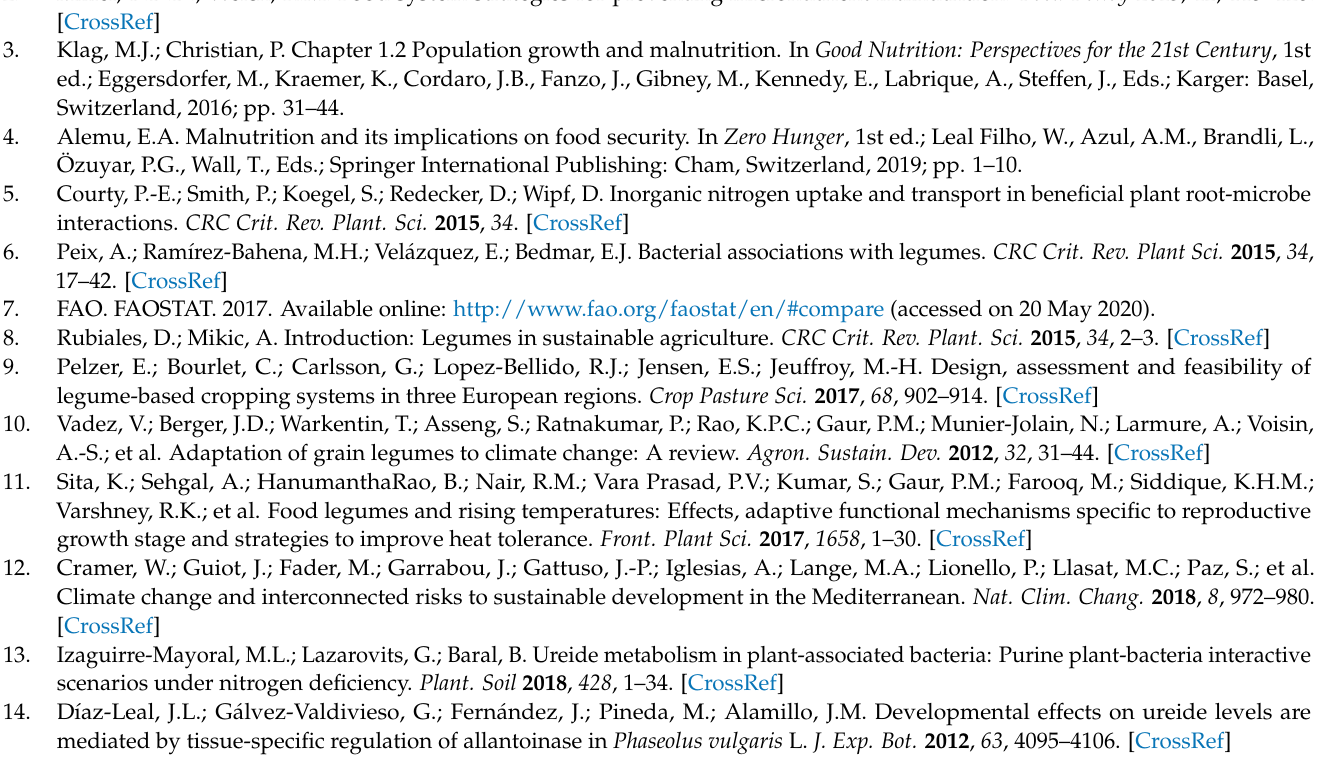
Table S8: Amino acid scores of individual amino acids for the different common bean accessions cropped in C ó rdoba ( n = 72) by comparison with the scoring pattern recommended for children from 2to 5 years old [33]. Table S9: Contents of non-essential amino acids, average ± SD (standard deviation), g/16gN (100g of protein), in the different Portuguese common bean accessions cropped in C ó rdoba ( n = 72). Different letters per column indicate significant differences between accessions ( p < 0.05). Table S10: Trypsin inhibitor activity (TIA), mg/g, measured in the different Portuguese common bean accessions cropped in C ó rdoba ( n = 72). Different letters indicate significant differences between accessions ( p <